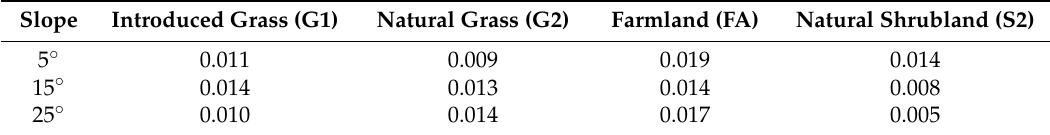
Table 1. The mean value of K in runoff plots (revised universal soil loss equation (RUSLE) estimate